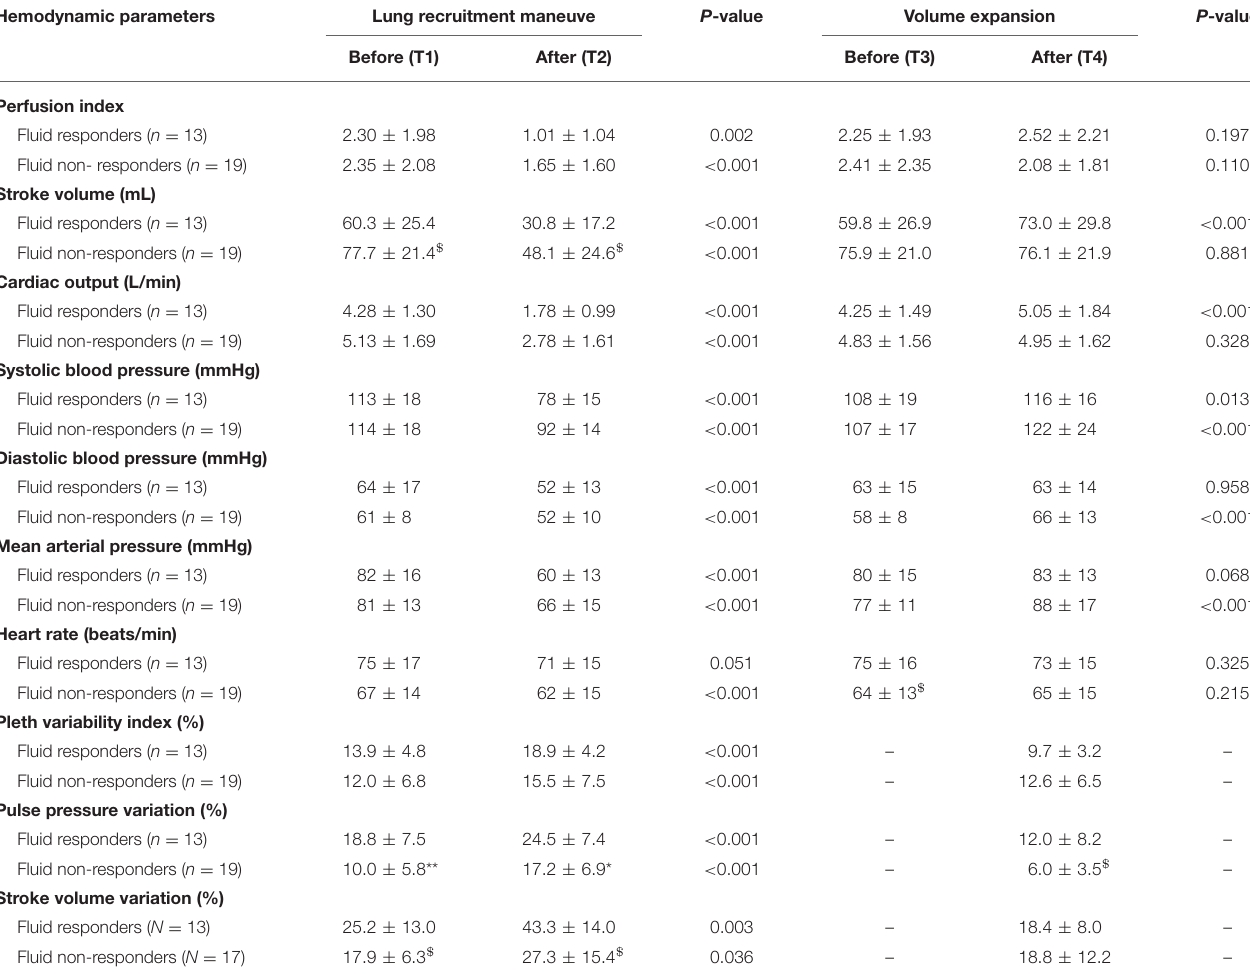
TABLE 2 | Hemodynamic parameters before and after lung recruitment maneuver and volume expansion. Hemodynamic parameters Lung recruitment